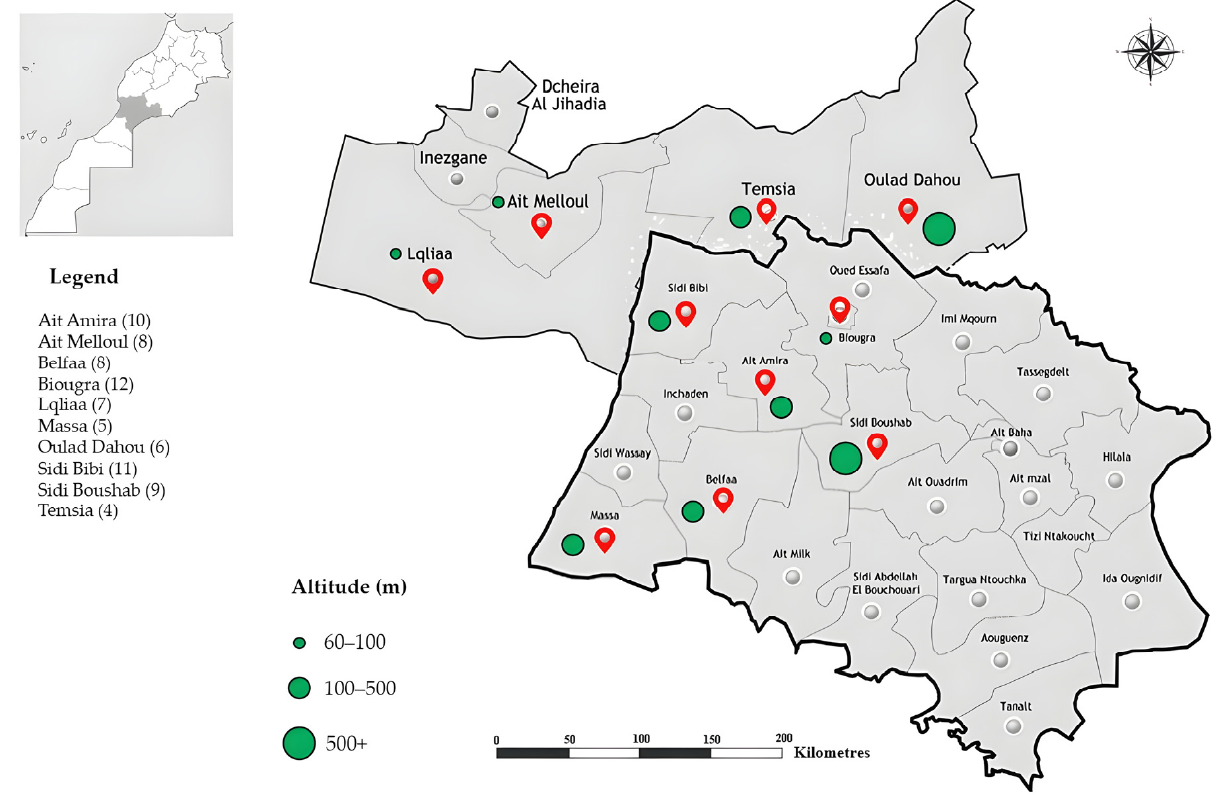
Figure 1. Map of distinct localities surveyed for nematodes in the Southern region of Morocco.